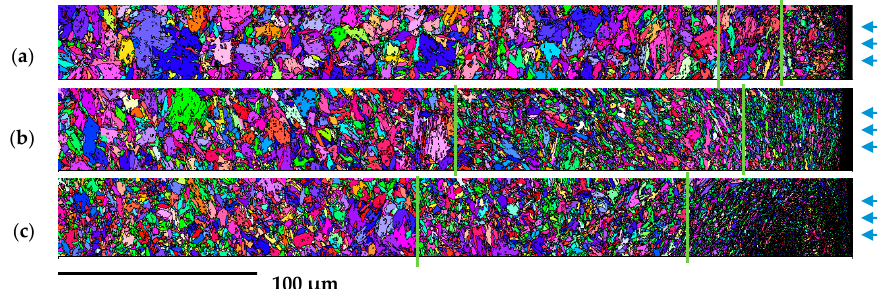
Figure 3. Inverse pole figure (IPF) of shot peened samples with a misorientation of >15°, a scan area of 400 × 30 µm 2 , and a step size of 200 nm. The arrows are indicating the shot peening direction, ( a ) CSP, ( b ) SSP5, and ( c ) SSP10.